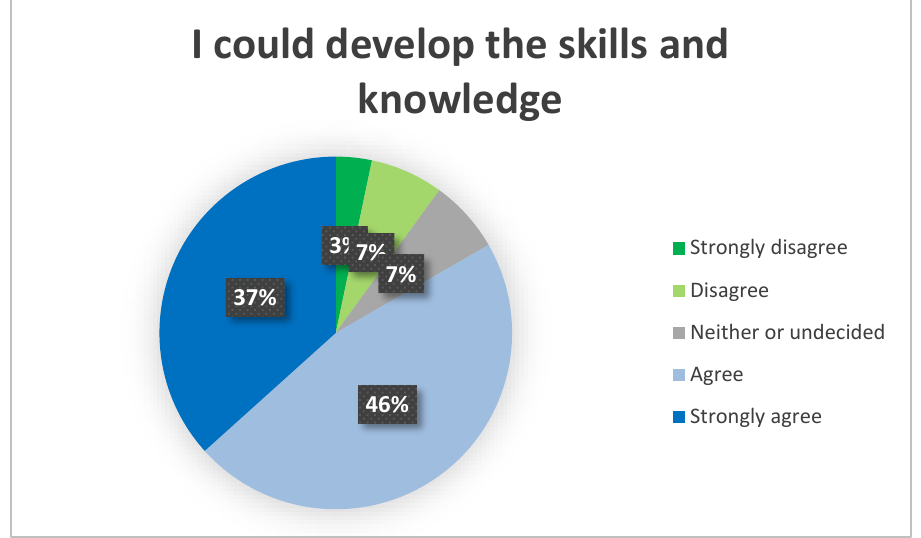
Figure 5. Industry agreement with the statement “I could develop the knowledge and skills needed to use tissue culture trees in my role with the right information available”.